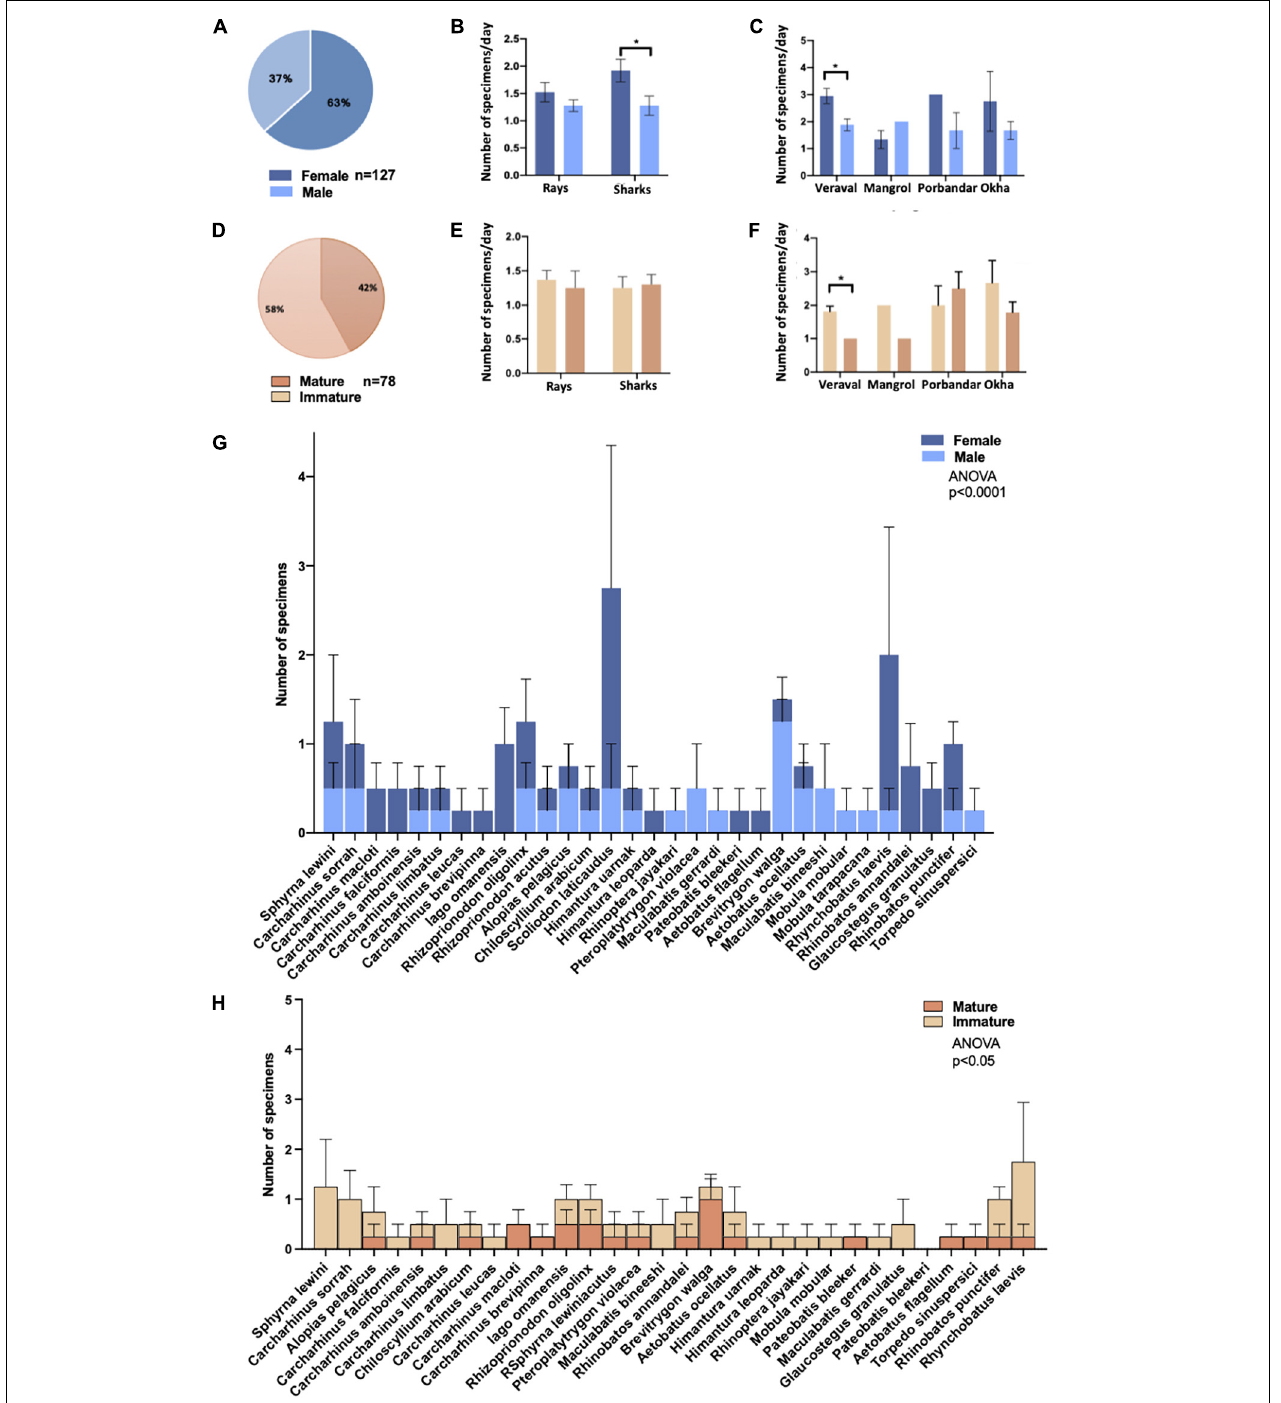
FIGURE 5 | Frequency distribution of sharks and the rays by sex and maturity across sampling locations. Sex determination of (A) all samples ( n = 117) in which determination could be made, including samples with no species identification, (B) by shark and ray specimens, and (C) by sampling location. A comparison of the ratio of young to mature adults (D) among all specimens ( n = 77), (E) between sharks and rays, and (F) between sampling locations. Comparison of male and female specimens in all species in (G) and comparison of mature and immature specimens of each species except Scoliodon laticaudus in (H) . Two-way ANOVA with multiple comparisons between the respective groups was performed in (B,C,E–H) . Asterisk * denotes a significant difference ( p ≤ 0.05) and *** denotes a highly significant difference ( p ≤ 0.0005) between groups. We compared total population distribution of males vs. females in (G) and mature vs. immature specimens in (H) . Distribution of males vs. females and of mature vs. immature individuals was significantly different as indicated by respective p values. S. laticaudus was identified as an outlier and removed from analyses in (H) .